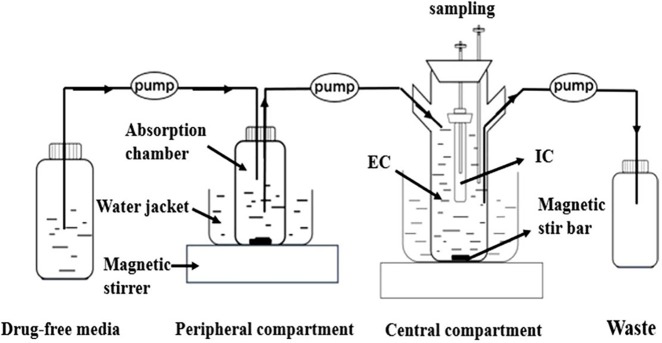
The in vitro model that simulates the pharmacokinetics of doxycycline and determines a drug’s effect on the growth and susceptibility of M. hyopneumoniae.